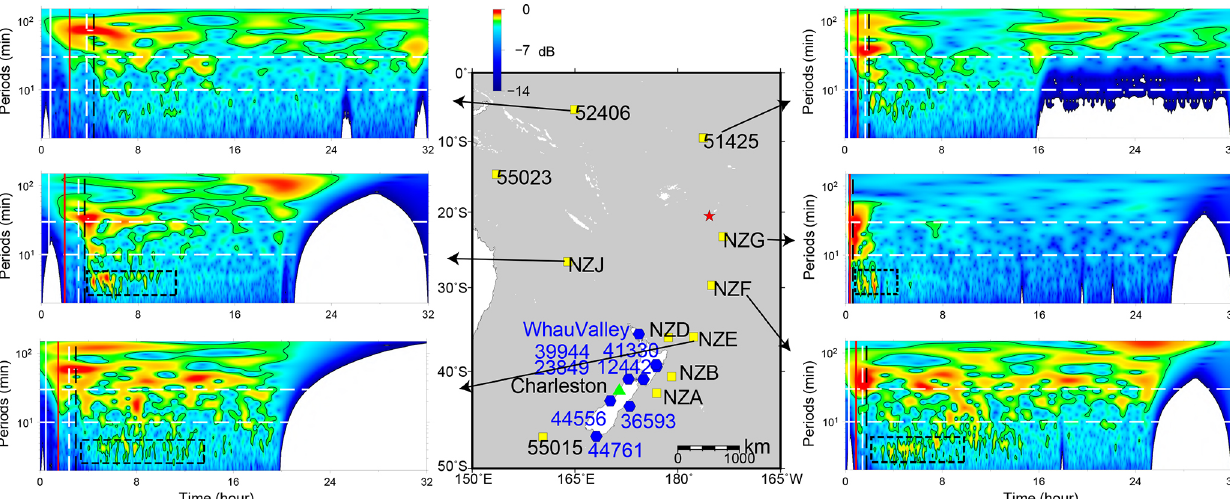
Figure 5. Wavelet analysis of representative DART buoys in vicinity of the HTHH volcano. In each subplot, the solid vertical white lines mark the arrival time with a travelling velocity of 1000ms − 1 . The solid vertical red lines mark the arrivals of Lamb waves. The dashed vertical white lines mark the lower limit of AGWs’ velocity of 200ms − 1 (Kubota et al., 2022). The dashed vertical black lines represent the theoretical tsunami arrivals. The dashed horizontal white lines mark two reference wave periods of 10 and 30min. The blue hexagons represent the locations of barometers. The green triangle marks the location of the tide gauges at Charleston. The decibel (dB) metric is calculated as dB = 10log (A/A 0 ) , where A is wavelet power and A 0 is a reference wavelet power of the maximum one (Thomson and Emery, 2014).